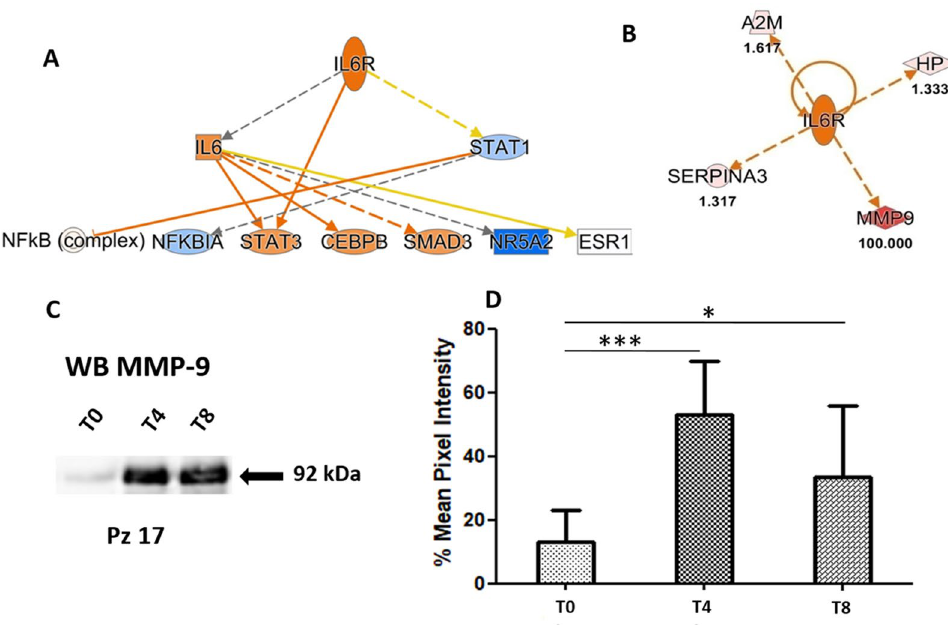
Figure 3. Tear functional proteomics results after 8 weeks of treatment. ( A ) Interleukin-6 receptor (IL6R) resulted the most significant activated Upstream by comparing proteomics dataset at T0 and T8 timepoint of treatment with rhNGF . ( B ) Identified proteins related to the activation of IL6R .Colour key and symbols are reported in the Fig. 2. ( C ) Matrix metalloproteinase-9 (MMP-9) expression in one representative NK patient at T0, T4 and T8 timepoint during therapy. ( D ) Histograms reporting the mean of six patients of OD pixel intensity in percent of the MMP-9 band (92 kDa). MMP-9 expression in each patient at T0, T4 and T8 is reported in the WBs of Supplementary Fig. S1. Multiple exposure time points, as well as the full-length blots are shown in Figs. S2 and S3. Error bars show the standard error of the mean from six NK patients at the different times of treatment. * means p-value < 0.05, *** means p-value < 0.001 at the Student’s